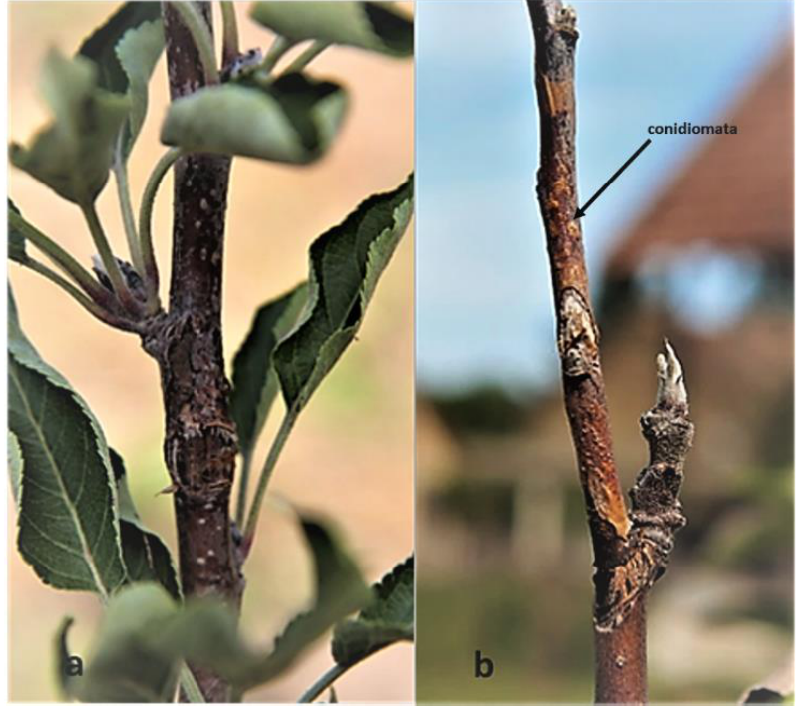
Figure 3. Two type of symptoms caused by Neofabraea sp. on apple branches: ( a ) developed canker caused by isolate J129; ( b ) canker with visible conidiomata under surface of branches caused by isolate J67/2. Pictures were taken 10 months post inoculation.